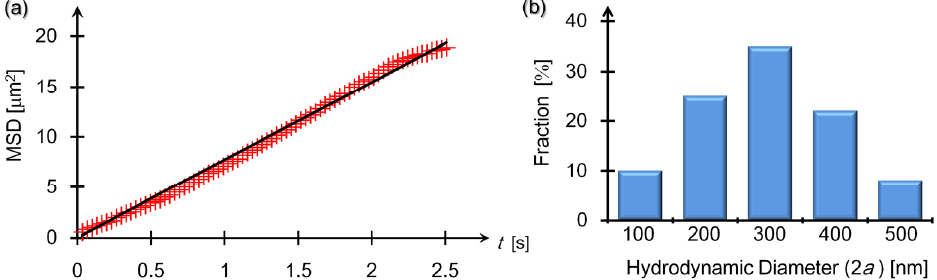
Figure 1. Time-interval ( t ) dependence of the MSD of a bare SB ( a ) and histogram representation of the diameter distribution of 50-particles that were recognized as bare SBs ( b ). ( a ) The line delineates Equation (1) that was fitted to the measured MSD (red crosses). Error bars lie within symbols. ( b ) A percentage denotes a mean fraction of 50 particles which depends on a range of hydrodynamic diameter. For example, the label “100” in the transverse axis represents the range 100 ≤ 2 a <